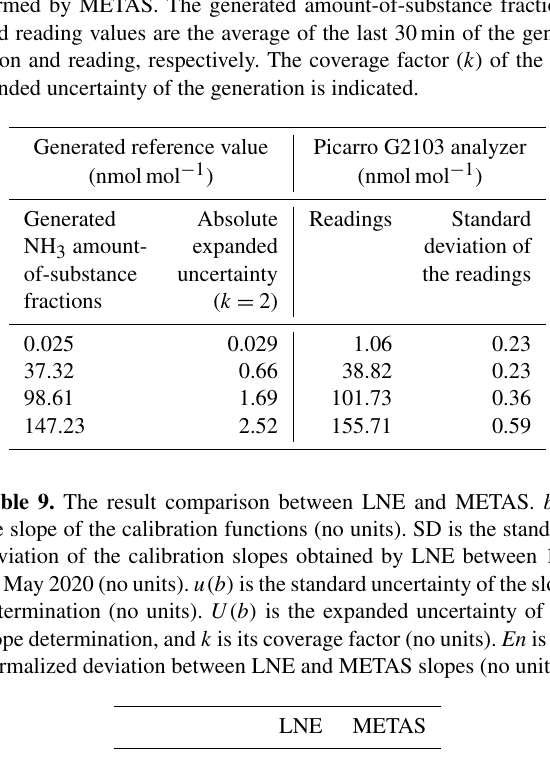
Table 6. The reproducibility of the determination of the calibration function of an ammonia analyzer.